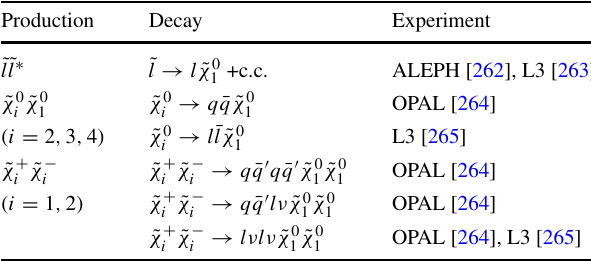
Table 4 Results from LEP on sparticle pair production used in the scans of this paper. Here ˜ l = ˜ e L , ˜ e R , ˜ μ L , ˜ μ R , ˜ τ 1 or ˜ τ 2 Production